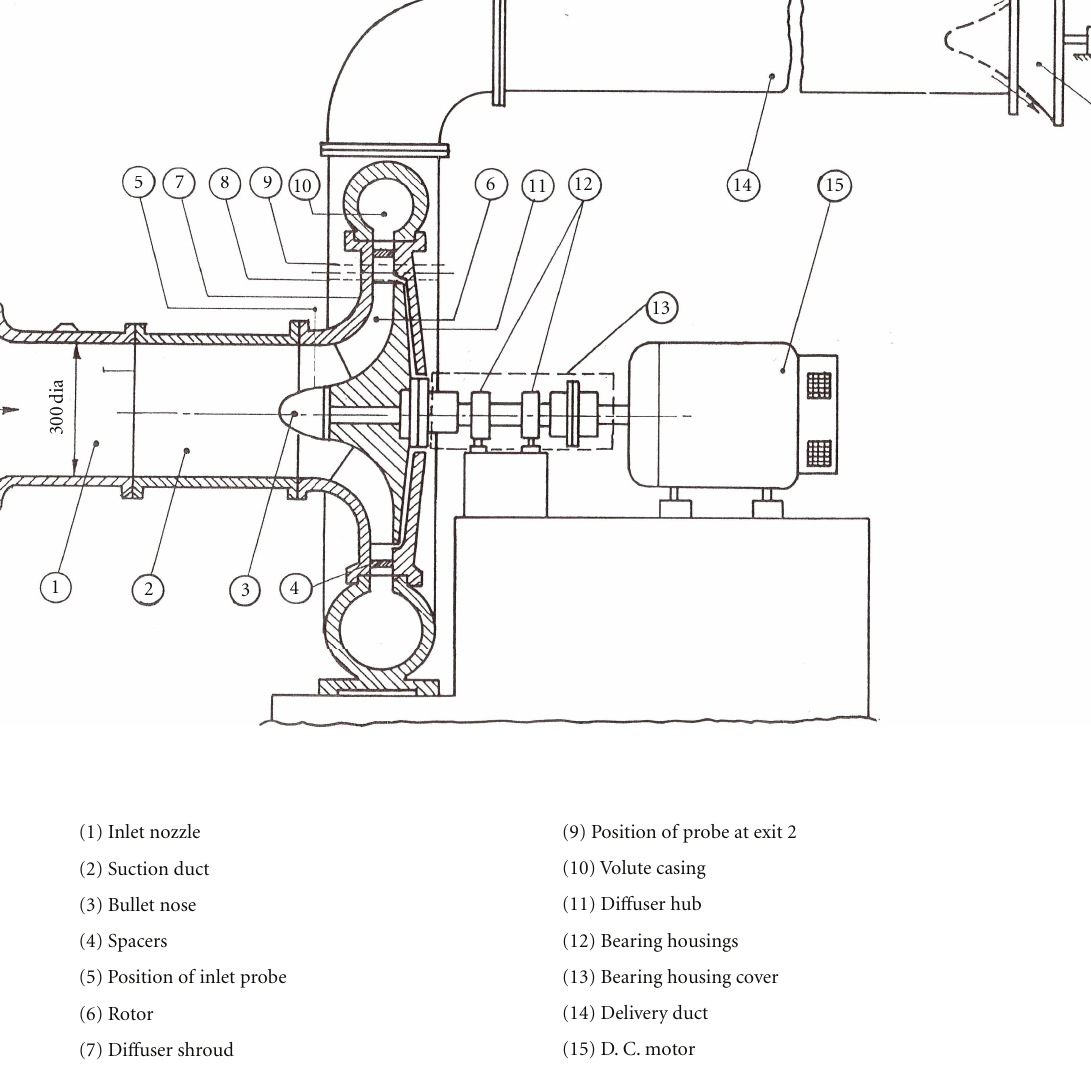
Figure 1: Schematic diagram of centrifugal compressor